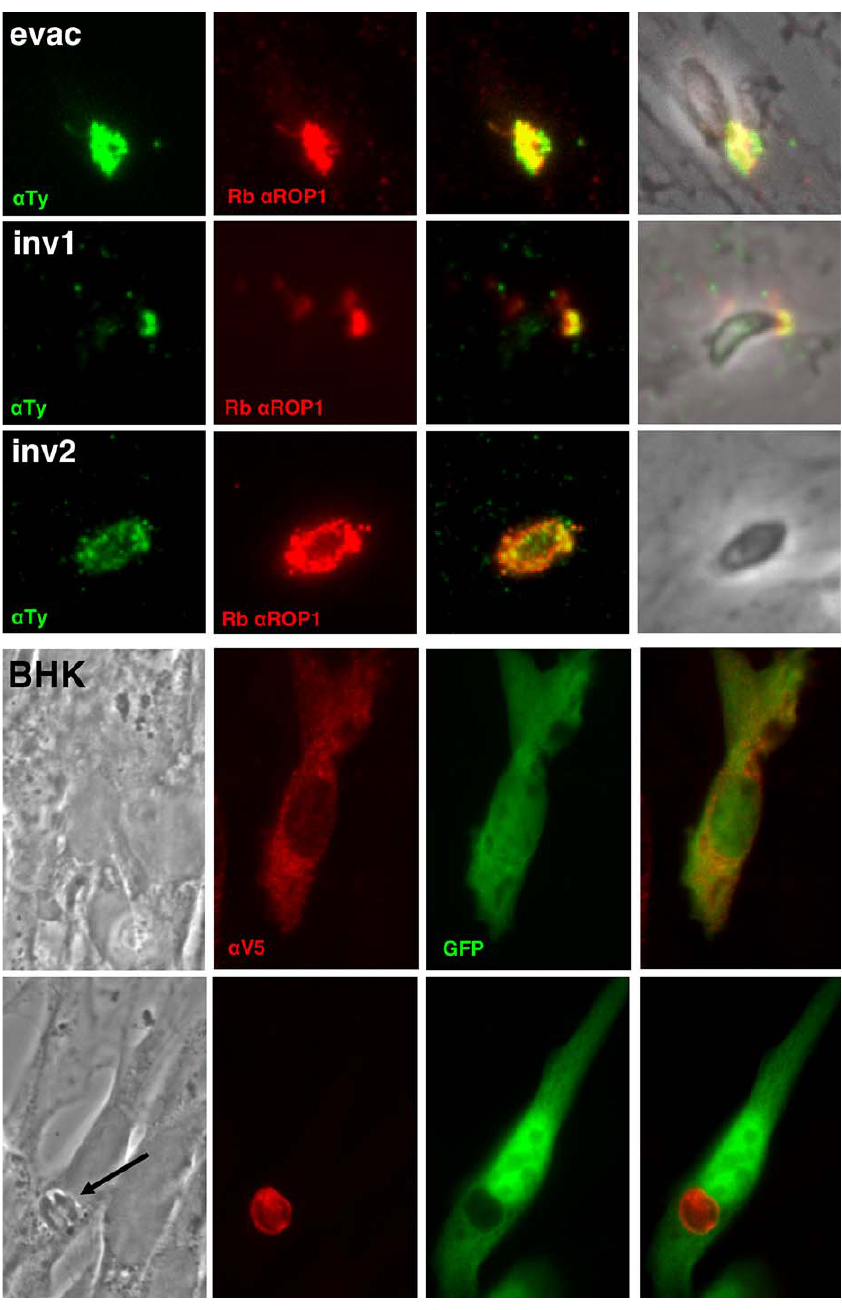
Figure 6. ROP18 Is Secreted during Host Cell Invasion and Associates with the PVM The upper panel shows evacuoles of a Cyt-D–arrested ROP18Ty parasite (evac), of an invading tachyzoite (inv1), and of a newly invaded tachyzoite (inv2) of the same clone, all reacted with mAb anti-Ty and rabbit anti-ROP1 antibodies. In all cases, the ROP1 and Ty labels co-localise, demonstrating the translocation of ROP18Ty in the evacuoles or in the PVM. The lower panel shows two BHK cells that have been transfected with Plasmid pTracer-ROP18 D Pro, one of which was infected later by T. gondii (arrow). Both cells express GFP in the cytosol; in the non-infected cell, the V5 epitope is detected as dots scattered in all cytosol, whereas in the infected cell, it is restricted to the PVM, showing a strong tropism of ROP18 for this